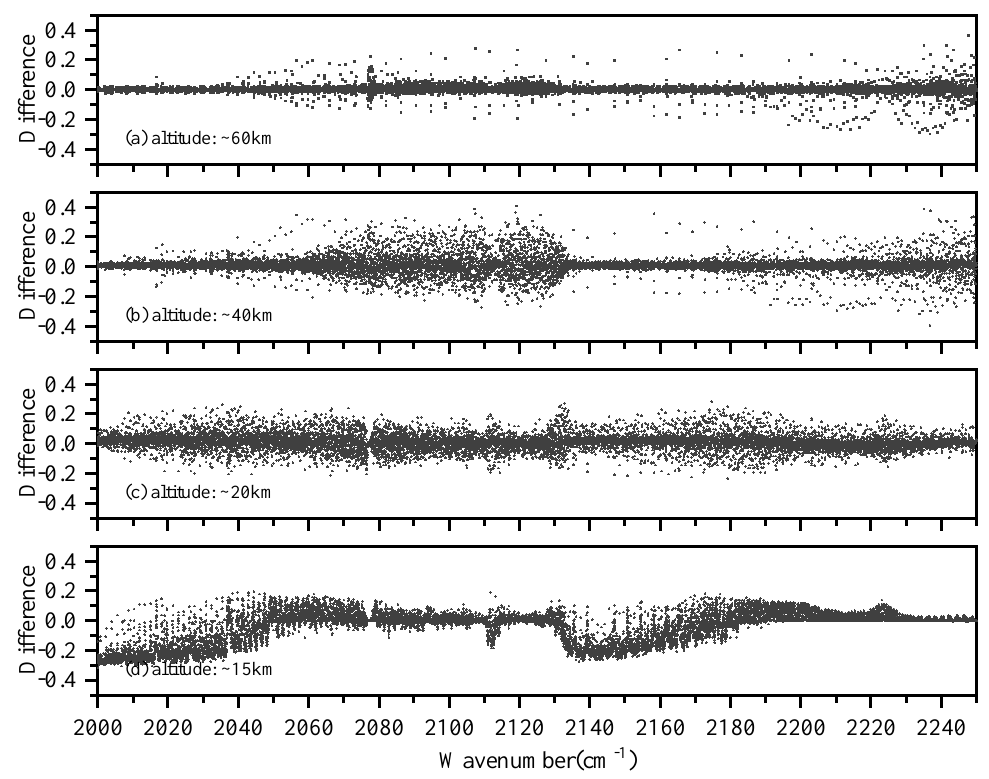
Figure A4. The transmittance differences between AIUS measurements and simulations in 2000–2250 cm − 1 .